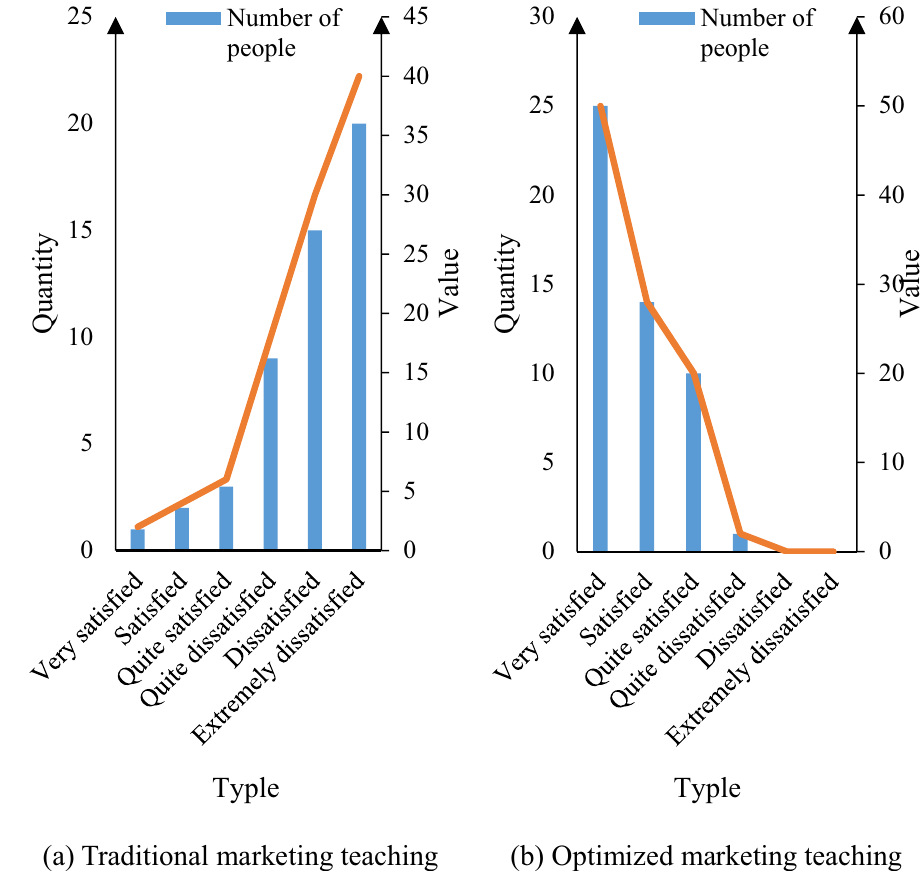
Fig. 6 Satisfaction of market- ing teaching of